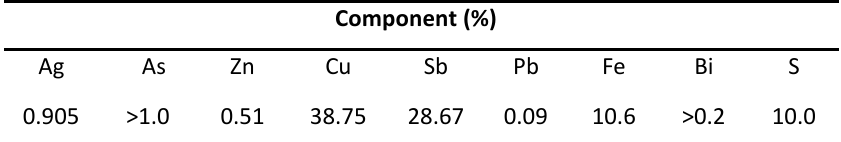
Table 2. Chemical composition of the polysulfide concentrate from the Asgat deposit